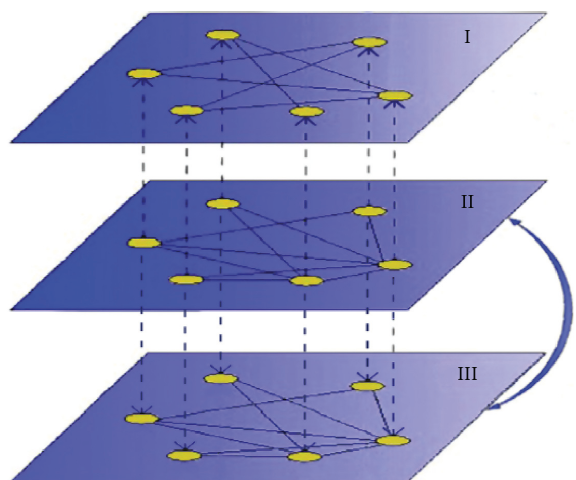
Figure 1: A schematic diagram [28] of generalized synchronization via the auxiliary system